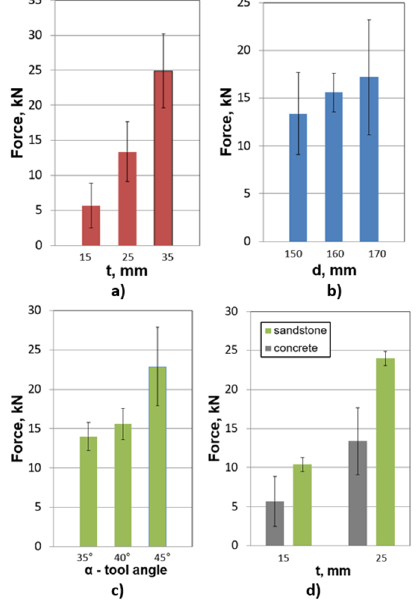
Figure 11. Mean values of maximum press forces for: ( a ) disk tool diameter D = 160 mm and sample compressive strength R c = 25 MPa, ( b ) mining spacing t = 25 mm, edge angle α = 40 ◦ and sample compressive strength R c = 25 MPa, ( c ) disk tool diameter D = 160 mm, mining spacing t = 25 mm and sample compressive strength R c = 25 MPa, ( d ) disk tool diameter D = 150 mm and sample compressive strength R c = 25 and 79 MPa.